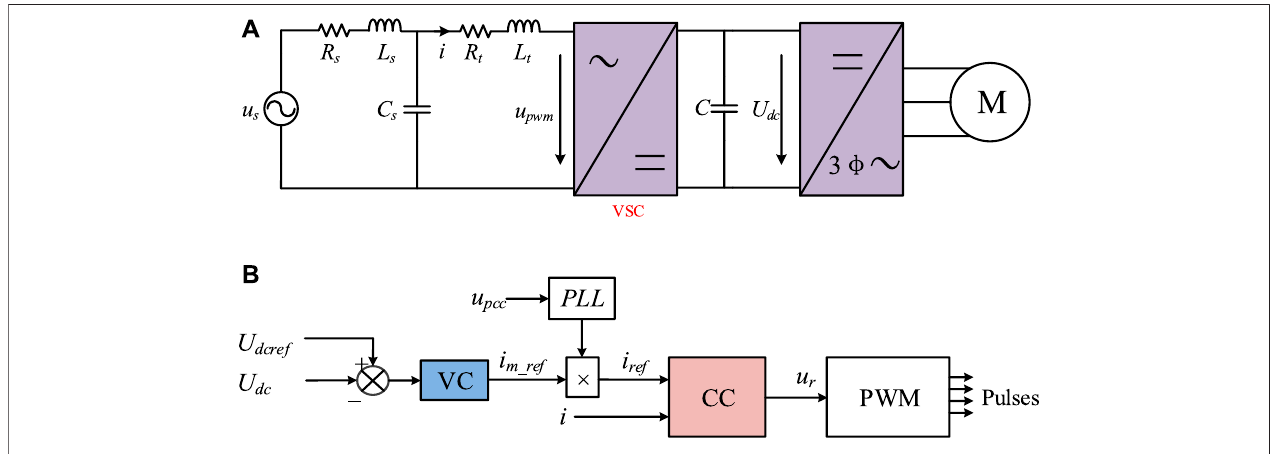
FIGURE 3 | The illustration of the L-N system and the controller of the VSC. (A) The simpli fi ed one-line diagram. (B) the double closed-loop controller of the VSC.